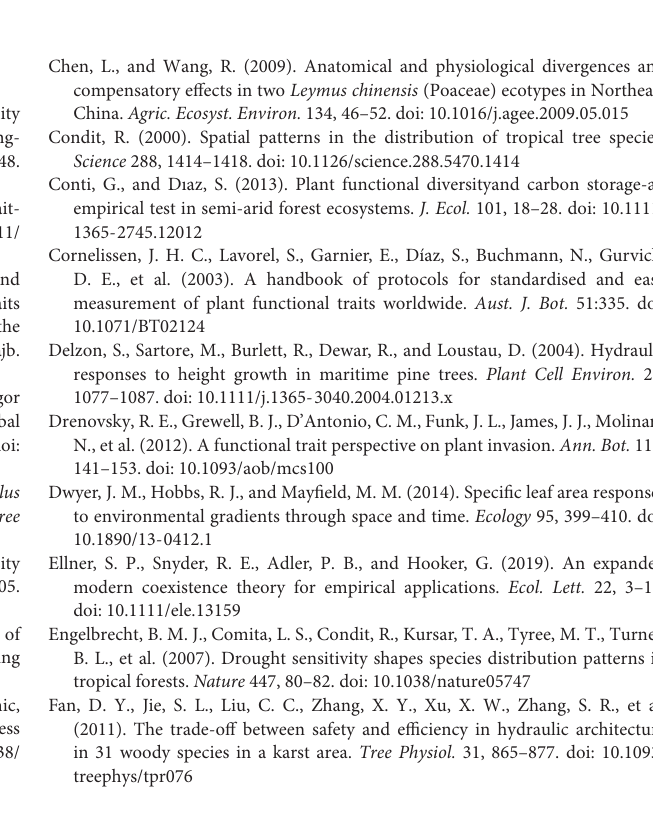
Supplementary Figure 1 | Barplot comparing soil water content (SWC) among per plot between LP and QL. Supplementary Figure 2 | Phylogenetic dendrogram of study site community species on LP. Supplementary Figure 3 | Phylogenetic dendrogram of study site community species in